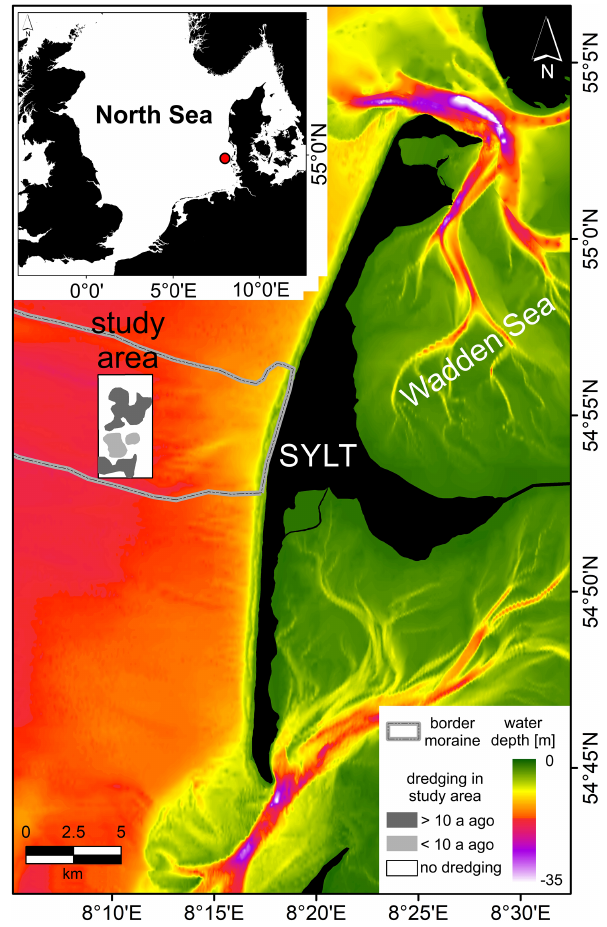
Figure 1. Study area “Westerland dredging area” (WDA) located west of the island of Sylt (SE North Sea). Bathymetric infor- mation was provided by the German Federal Maritime and Hy- drographic Agency (BSH, German Federal Maritime and Hydro- graphic Agency, 2018) and our own measurements. Geological data were modified after Streif and Köster (1978) (subaquatic border of the Saalian PISA